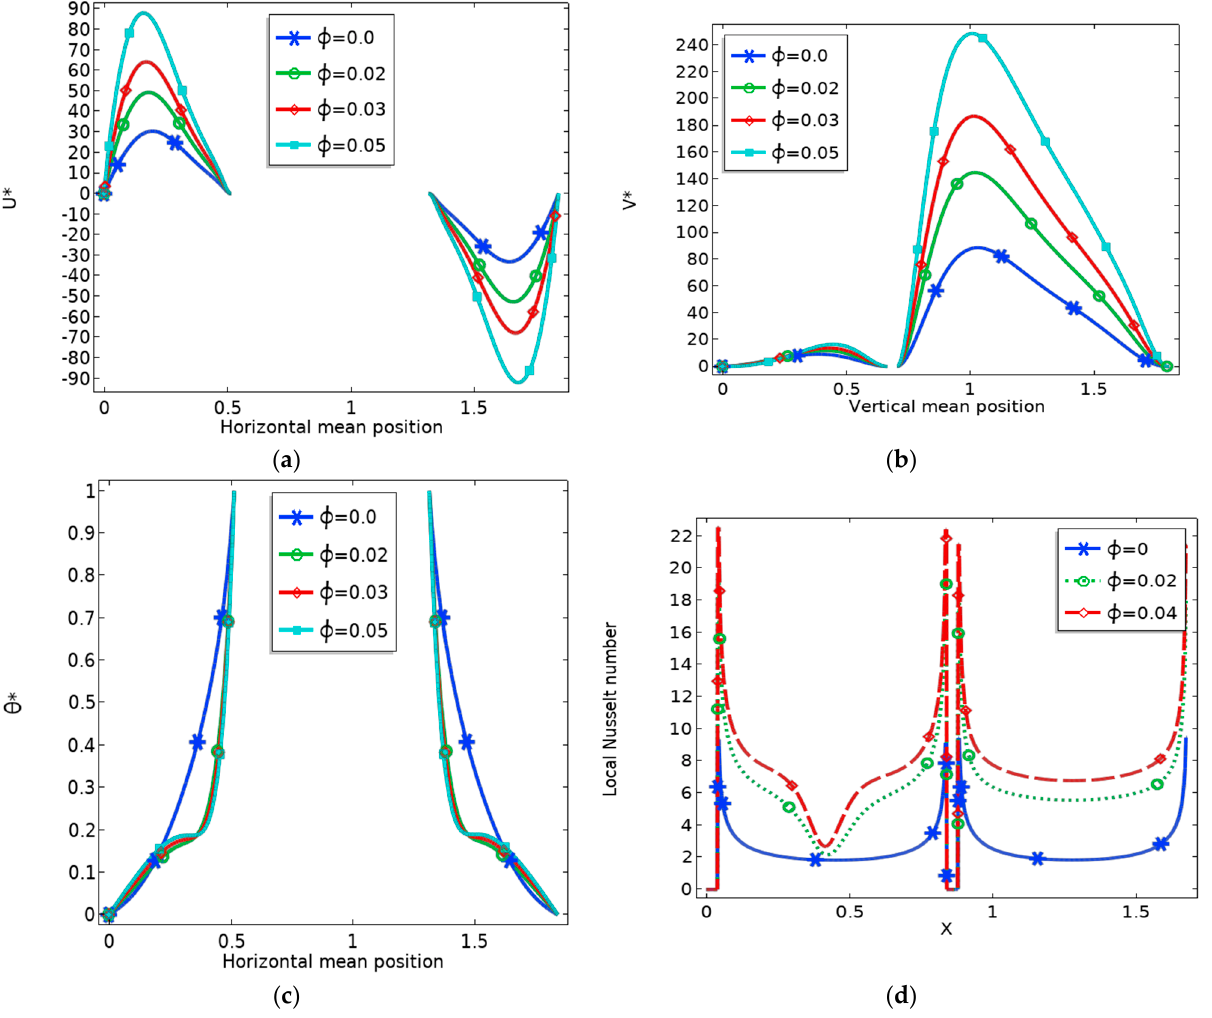
Figure 7. Variation of ( a ) horizontal velocity, ( b ) vertical velocity, ( c ) temperature, and ( d ) local Nusselt number with/respect to solid volume fraction ( 𝜙 ).